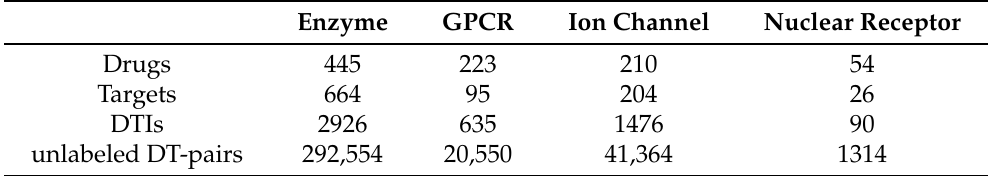
Table 1. Statistics of gold-standard